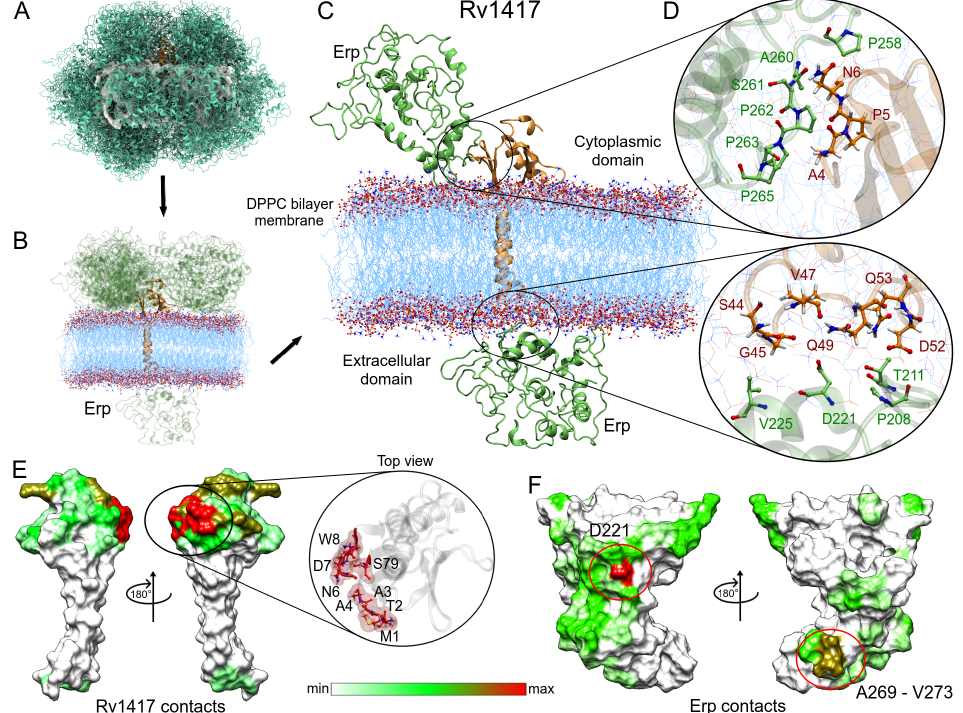
Figure 6. Analysis of the Erp–Rv1417 interactions. ( A ) Overall representation of the 100 energetically most favorable molecular complexes obtained in FireDock calculation. ( B ) Best complexes with effective protein contact. The up-side corresponds to the cytoplasmic environment, while the down- side to the extracellular domain. ( C ) Contact residues on the protein interface. Erp and Rv1417 residues are depicted in green and red–orange colors, respectively. ( D ) Zooms of the interface interactions. ( E , F ) Heat map of the main contacts between the Rv1417 protein and Erp protein. Red, green and white colors indicate a high or a medium number of residue contacts, or no contacts at all,